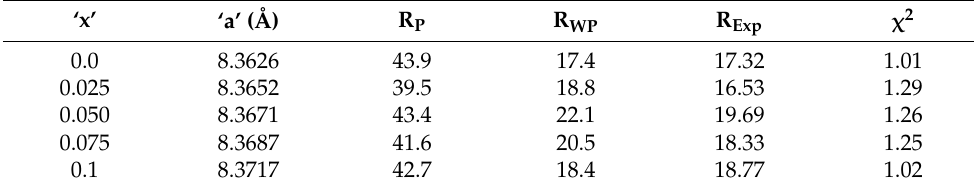
Figure 1. Rietveld refined XRD patterns of ( A ) x = 0.0, ( B ) x = 0.025, ( C ) x = 0.050, ( D ) x = 0.075, ( E ) x = 0.1 and ( F ) structure of CoCr 0.5 Dy x Fe 1.5 − x O 4 . Table 1. Rietveld Refined parameters of CoCr 0.5 Dy x Fe 1.5 − x O 4